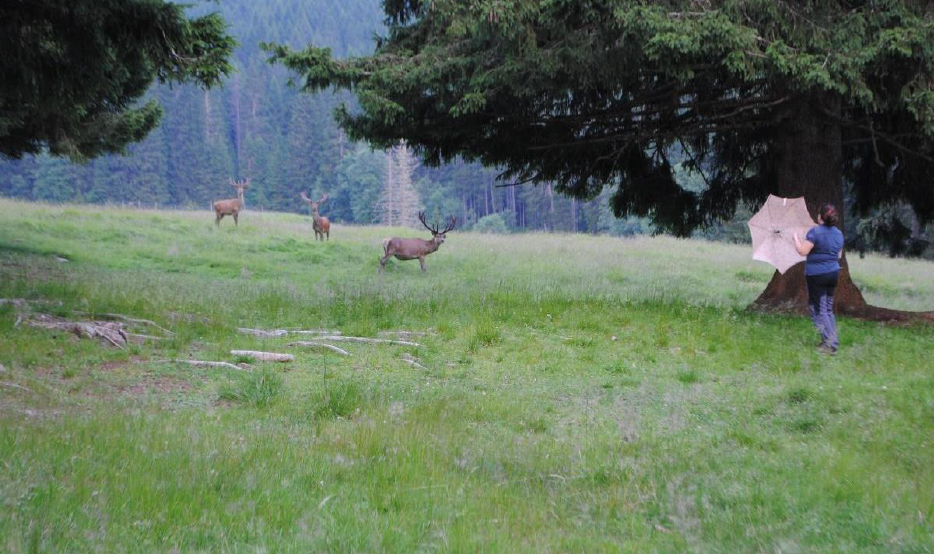
Table 1. Visual stimuli presented to the deer.